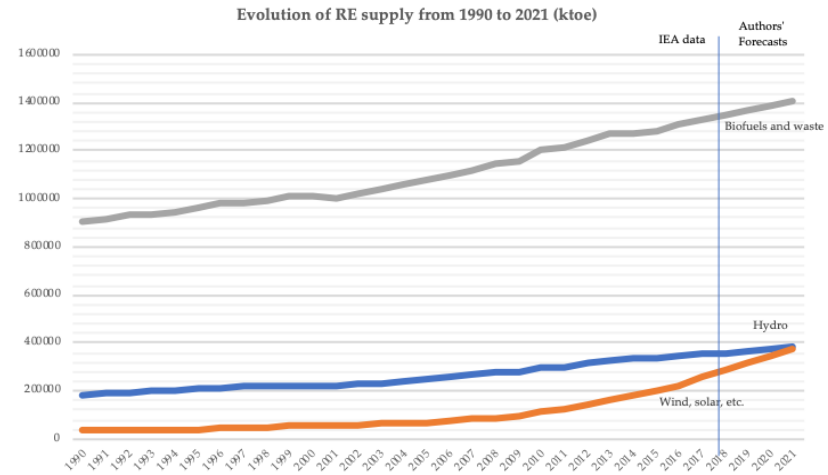
Figure 11. Evolution of renewable energy (RE) supply from 1990 to 2021 (Source: IEA and authors ’ forecasts).